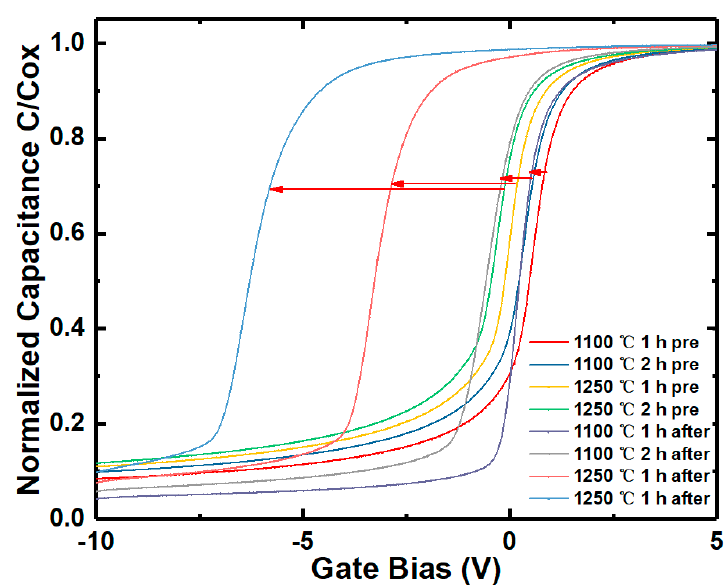
Figure 14. HF C-V characteristics of the samples with different nitriding process irradiated by same proton dose of 2 × 10 13 p/cm − 2 . Table 2. Extracted the shift of V FB and the variation of areal density of effective dielectric charge of the samples with different nitriding process irradiated by the same proton dose of 2 × 10 13 p/cm -2 .